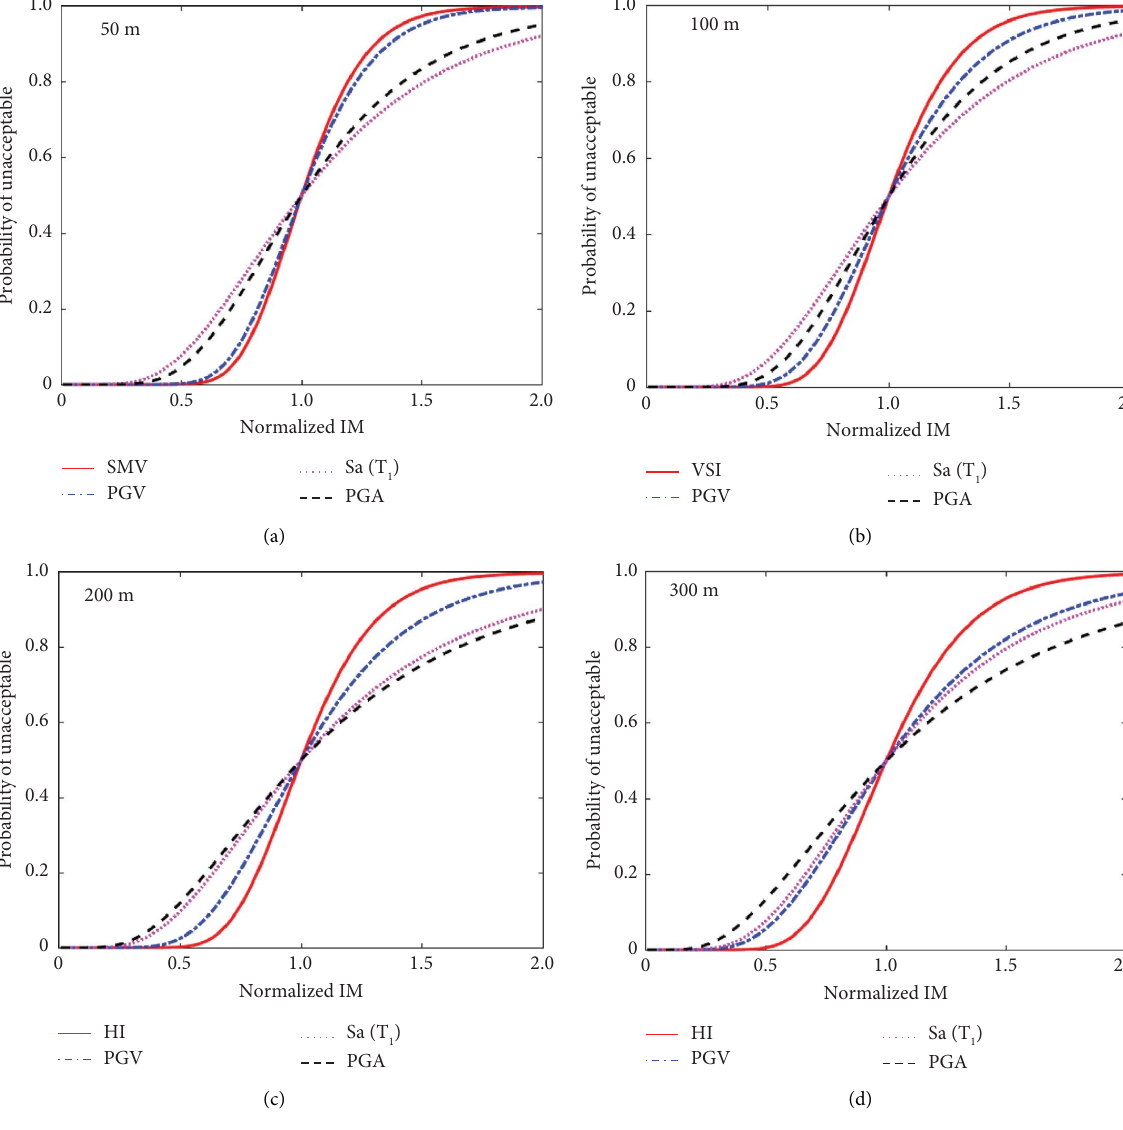
Figure 16: Unacceptable fragility curves using diferent IMs for the slopes with diferent mining depths. (a) 50m. (b) 100m. (c) 200m. (d) 300m.